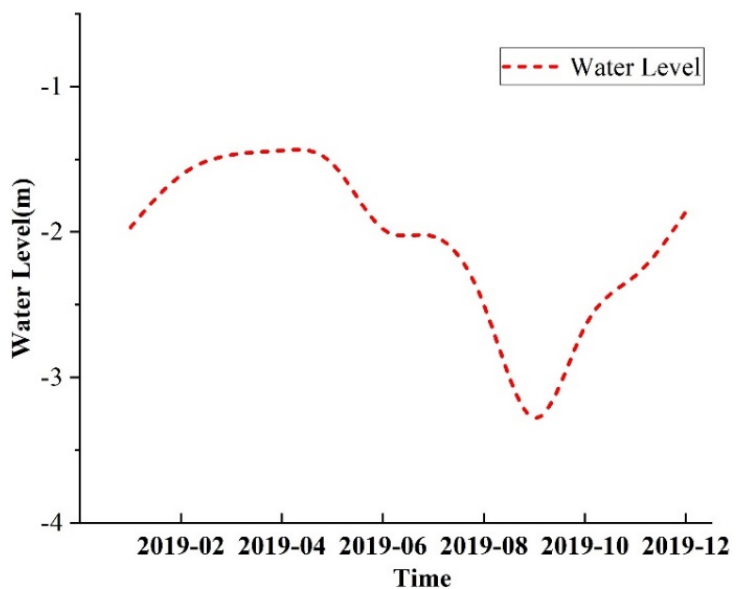
Figure 15. Water level change of water level monitoring point D in 2019.